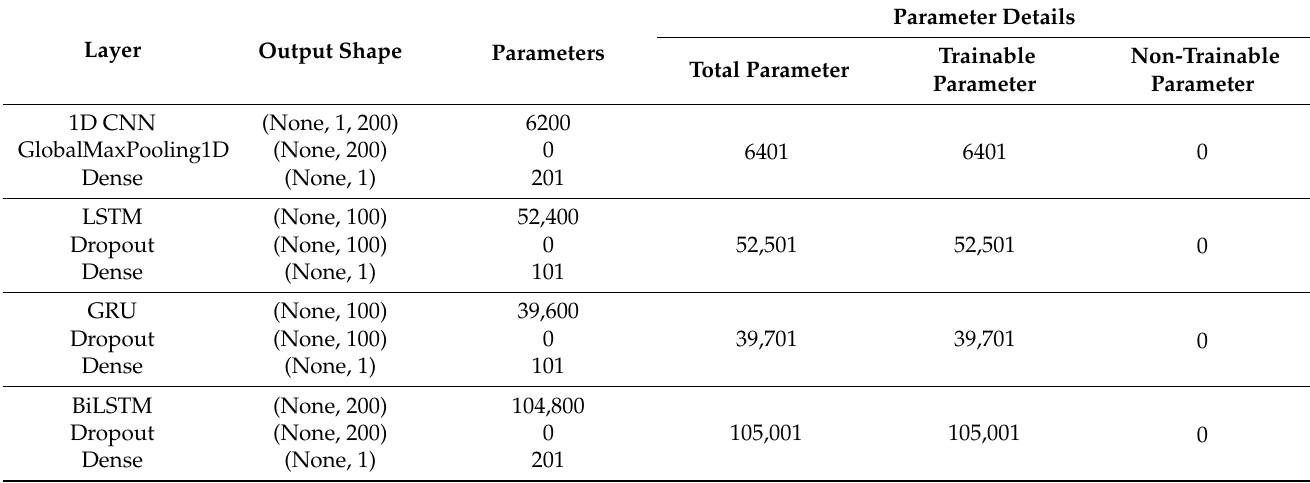
Table 3. Characteristics of the proposed deep learning models.